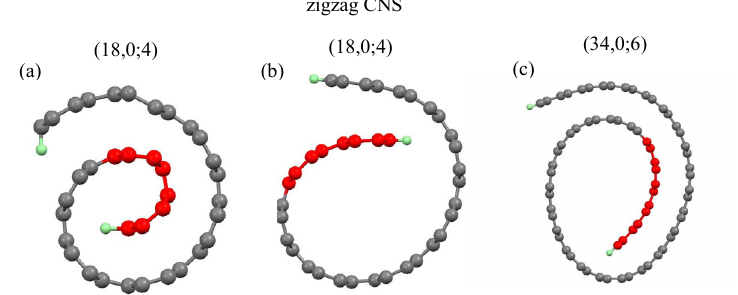
Figure 2. For zigzag carbon nanoscrolls: the ideal structure of ( a ) ( 18,0;4 ) and the optimal structures of ( b ) ( 18,0;4 ) , ( c ) ( 34,0;6 ) .